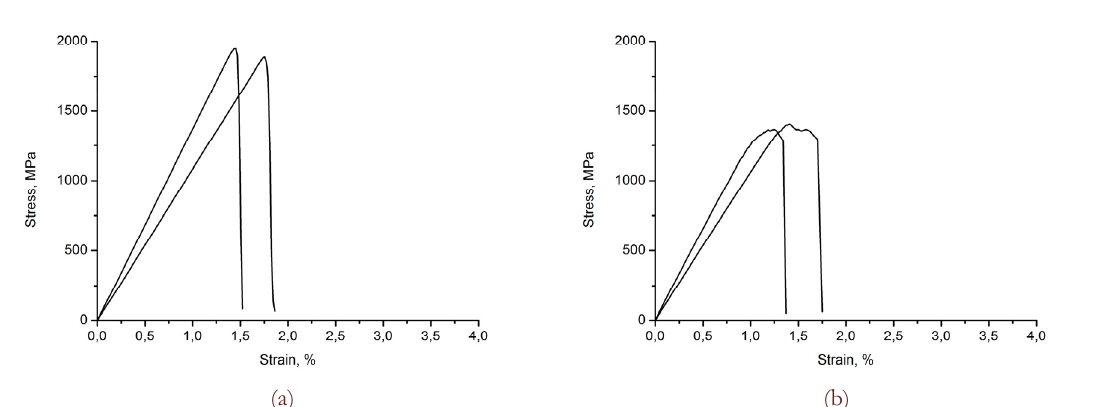
Figure 2: The   diagrams in case of: ideal sliding (a), friction (b) on the loading